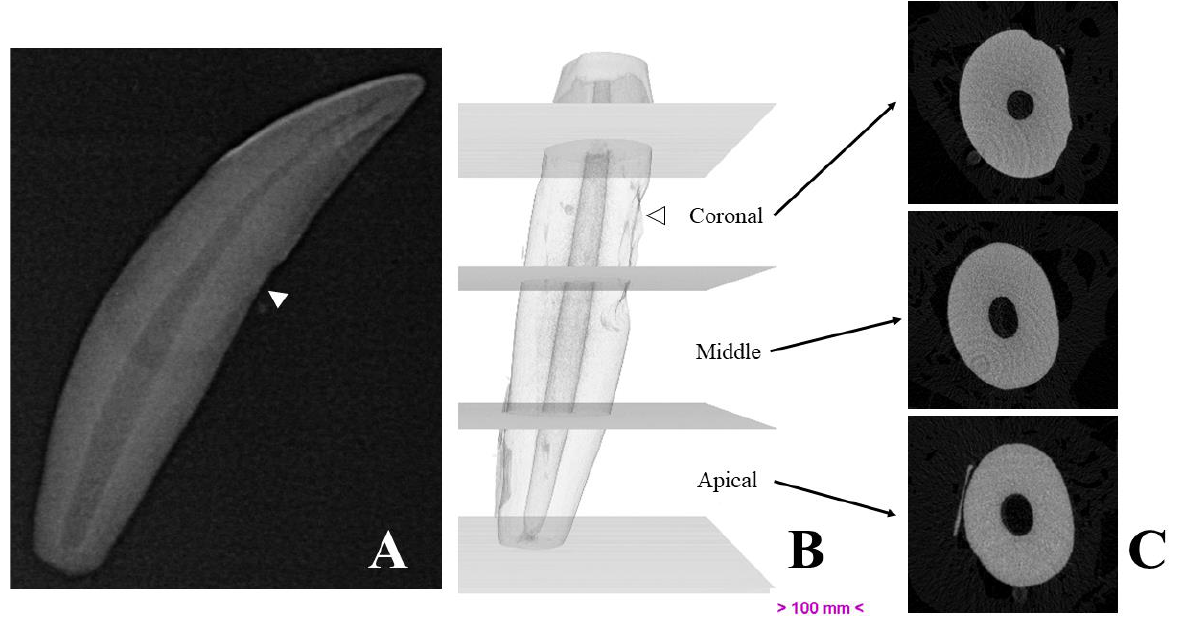
Figure 3. Representative images of a studied canine tooth. ( A )—Radiography. ( B )—Three-dimensional reconstruction, divided into thirds. ( C )—Cross-sections obtained by micro-computed tomography. White arrows show drill marks made during tooth extraction.